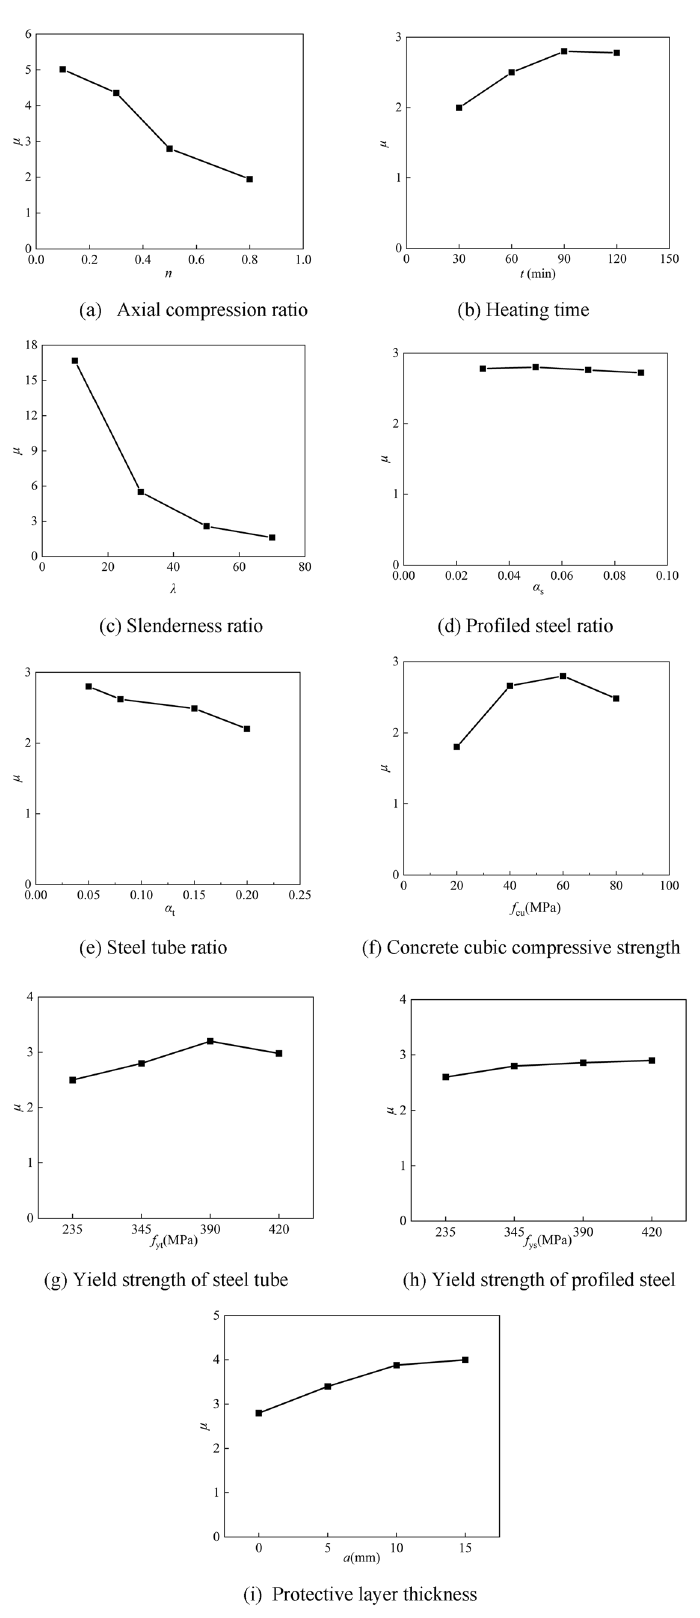
Figure 21. Analysis of ductility coefficient